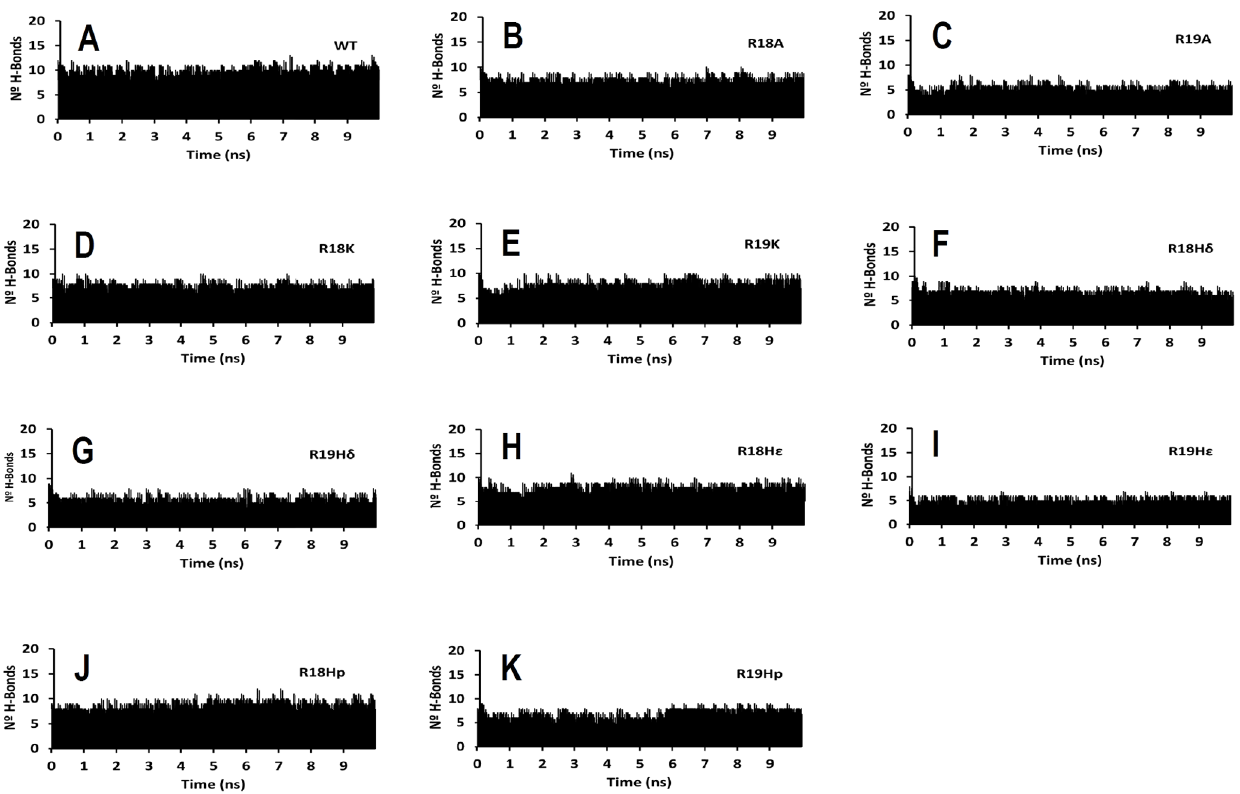
Figure 4. Number of HBs between the PKA and its substrates during 10 ns simulation time: (A) for WT, (B) for R18A, (C) for R19A, (D) for R18K, (E) for R19K, (F) for R18H d , (G) for R19H d , (H) for R18H e , (I) for R19H e , (J) for R18H p , (K) and for R19H p